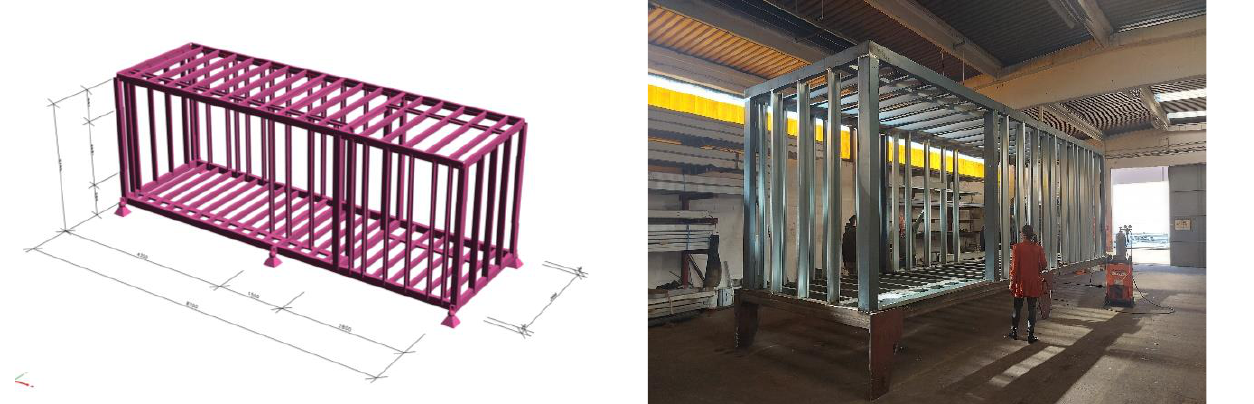
Figure 5. Load bearing steel structure of the MUZA: left — numerical model, right — realized structure.